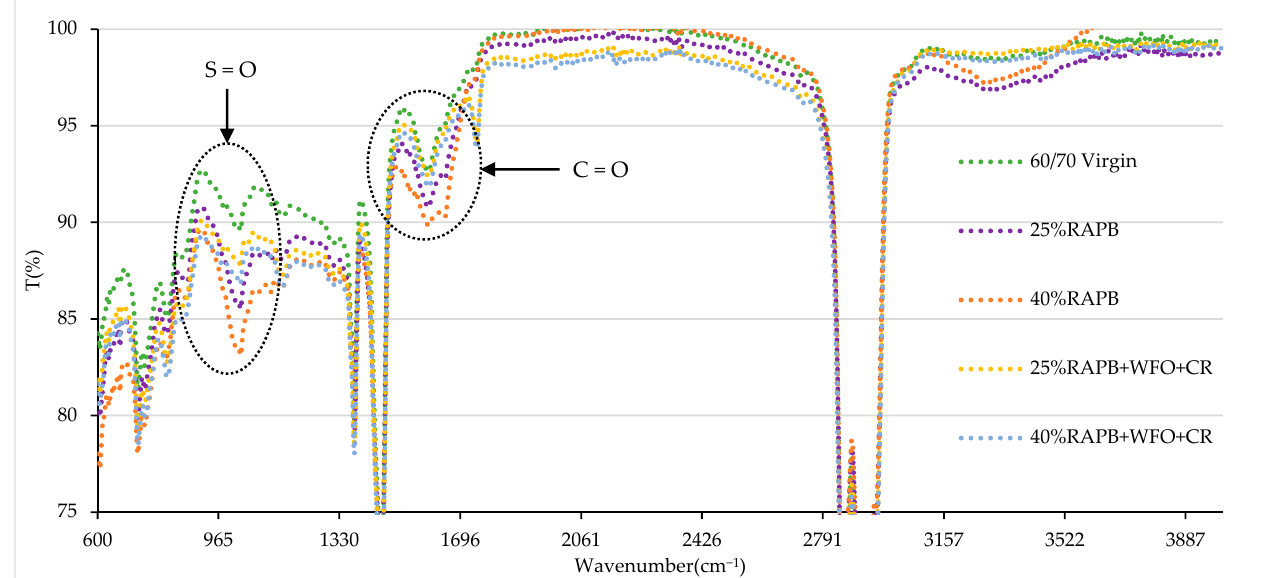
Figure 12. Complex modulus results of all binders.